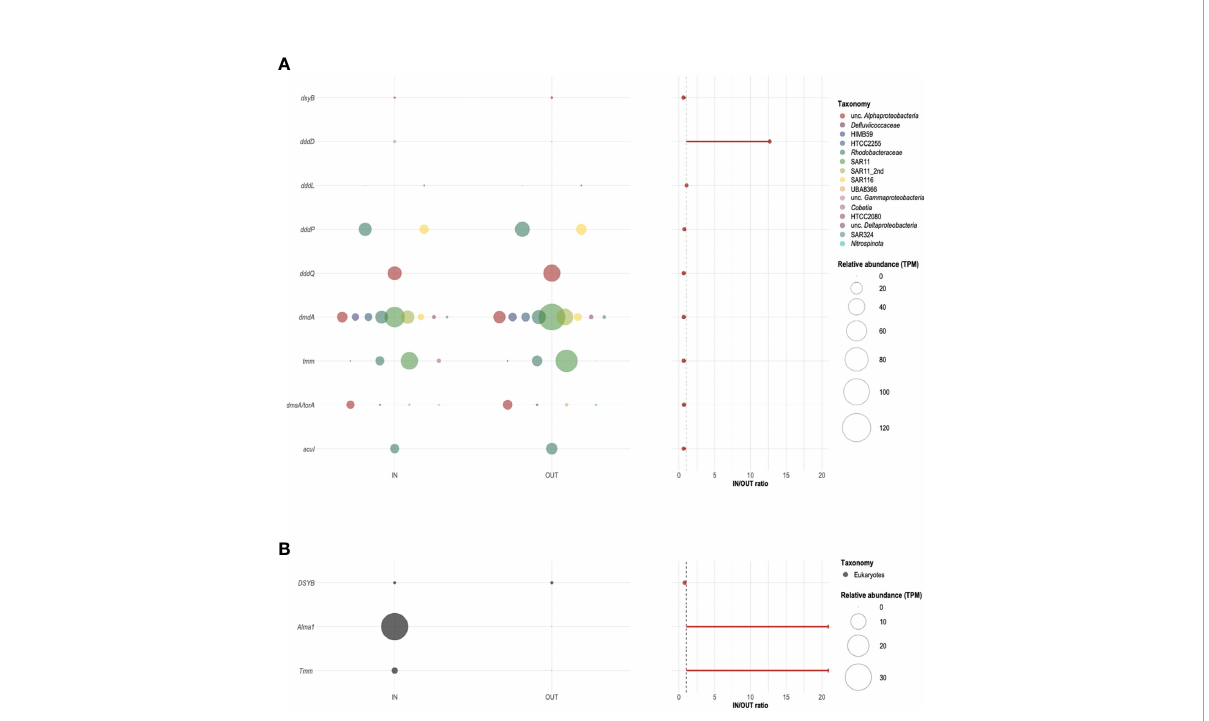
FIGURE 8 Relative abundance and taxonomic pro fi ling of potential bacterial (A) and eukaryotic (B) DMSPC-cycling genes around an Acropora pulchra colony. Bubble plots on the left show the relative abundance, expressed in transcript per million (TPM) of target genes ( dsyB , DSYB , Alma1 , dddD , dddL , dddP , dddQ , dmdA , tmm , dmsA / torA , and acuI ) identi fi ed in samples IN and OUT collected on 25 April 2018 at local noon. The colors of the bubbles indicate their taxonomic assignment. No sequences related to genes dddK, dddW , dddY , or dddX were detected in our metagenomes. The IN/OUT ratio of the relative abundance of each of the target genes is shown on the right. The dashed gray line corresponds to a ratio equal to